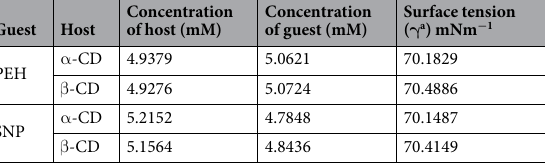
Table 1. Values of Surface Tension ( γ a ) at the Break Point with Corresponding Concentrations of DGs and CDs